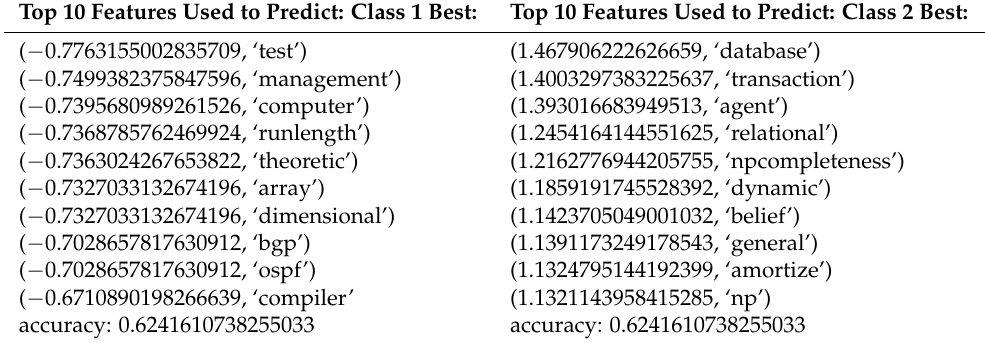
Table 3. Feature extraction. Top 10 Features Used to Predict: Class 1 Best: Top 10 Features Used to Predict: Class 2 Best: